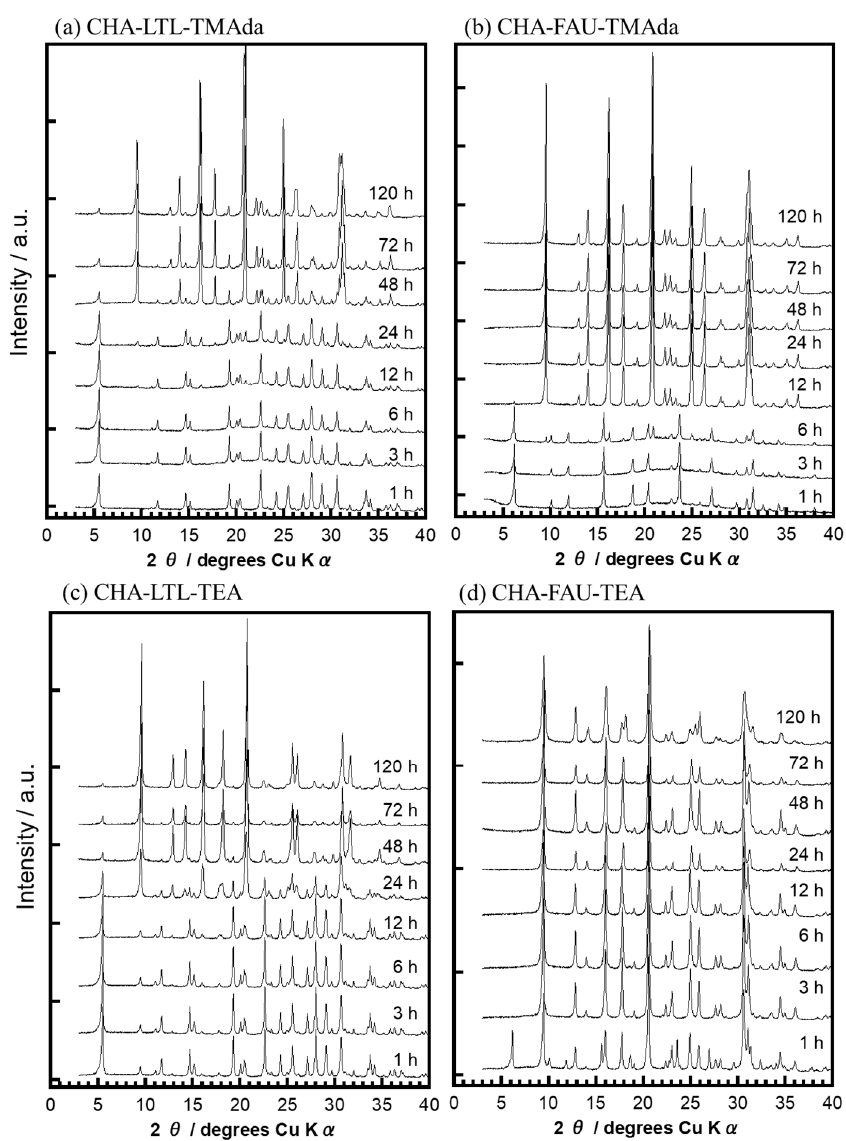
Figure 2. XRD patterns of ( a ) CHA–LTL–TMAda; ( b ) CHA–FAU–TMAda; ( c ) CHA–LTL–TEA and ( d ) CHA–FAU–TEA at different crystallization times.